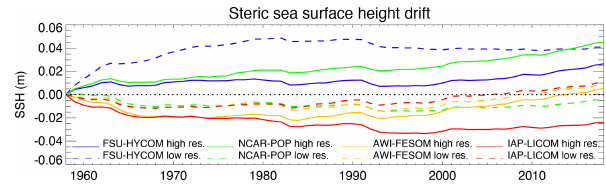
Figure 3. Time evolution from the initial conditions of the global steric sea surface height change for all